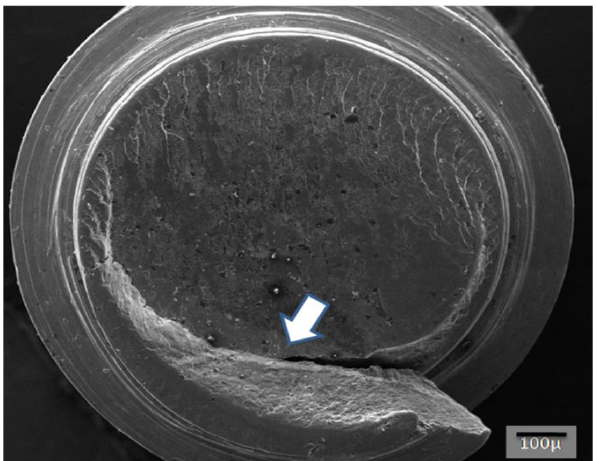
Fig 6. Scanning electron fractograph of the retrieved implant